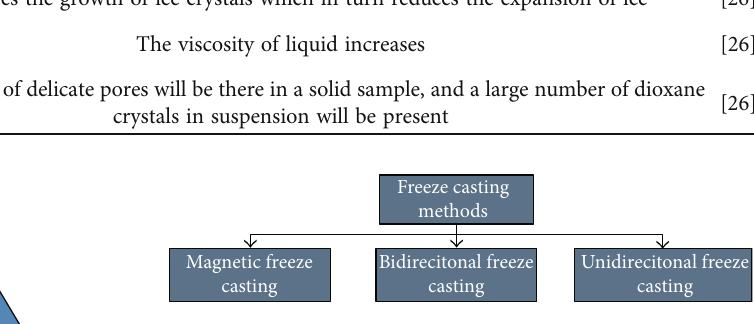
Figure 5: Types of freeze